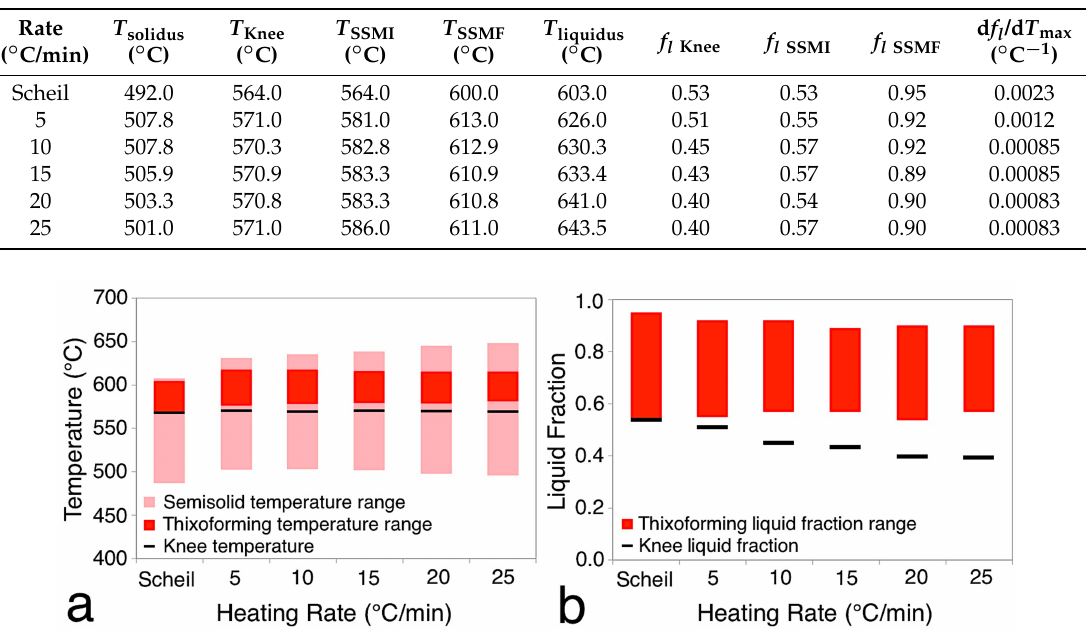
Table 3. Key thixoforming parameters obtained by the DM for B319+Fe alloy at different heating rates. The values predicted by numerical simulation (Scheil conditions) are shown for reference.